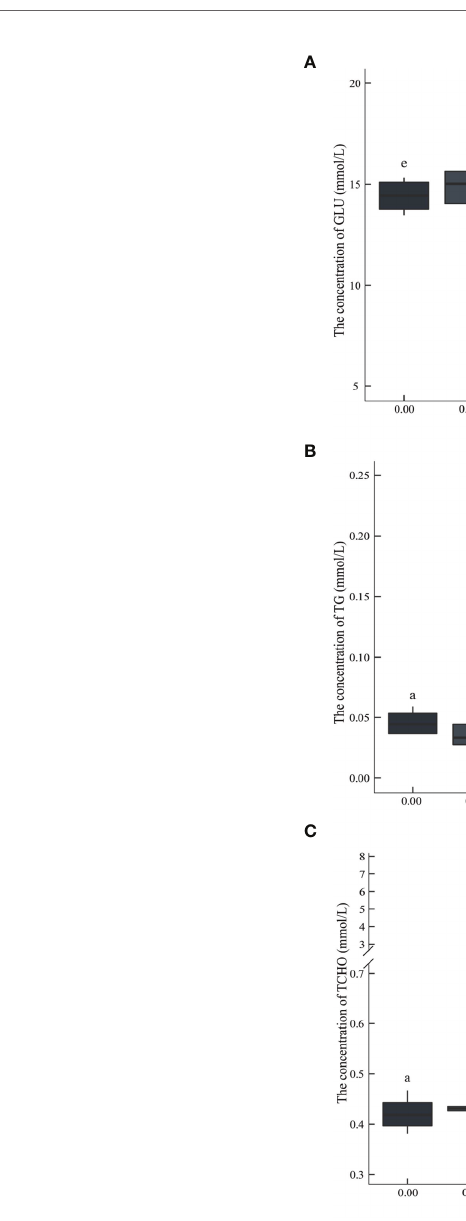
FIGURE 4 | Effect of different light intensities on the glucose (GLU) (A) , triglyceride (TG) (B) , and total cholesterol (TCHO) (C) contents in the hemolymph of juvenile Portunus trituberculatus . Data (n = 4) with different letters signi fi cantly differ ( P < 0.05) among